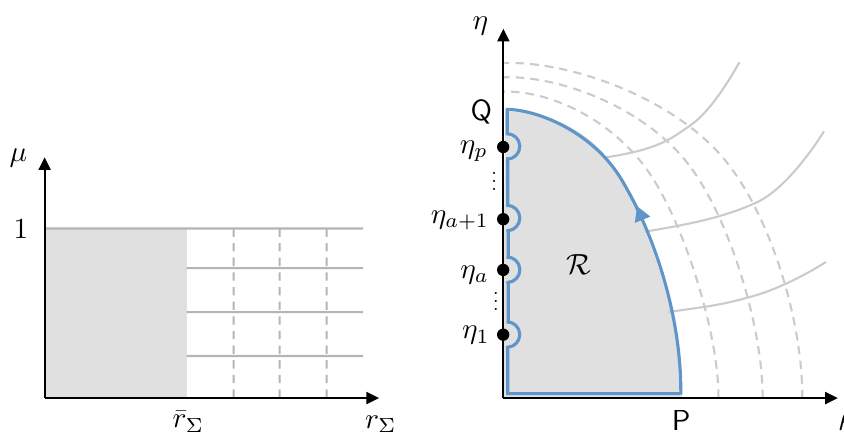
Figure 1 . On the left we depict the ( r Σ , µ ) plane. The relevant region is the strip r Σ ≥ 0 , 0 ≤ µ ≤ 1 . The shaded area corresponds to the portion D × S 5 that is excised to make room for the puncture. The value ¯ r Σ is the radius of the disk D . We also include lines of constant r Σ and lines of constant µ . On the right we depict the ( ρ, η ) plane. The region R corresponds to the relevant portion of the puncture geometry X 7 . The portion of the ( ρ, η ) plane outside the region R corresponds to the bulk of the Riemann surface. We depict the qualitative behavior of lines of constant r Σ and µ as they appear in ( ρ, η )